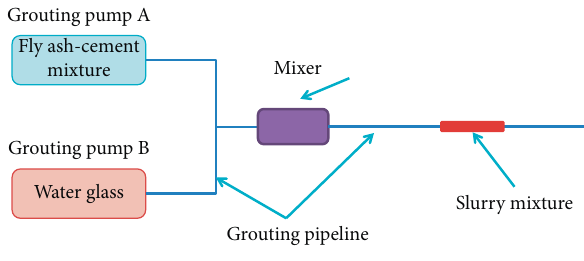
Figure 3: Pumpability testing principles.